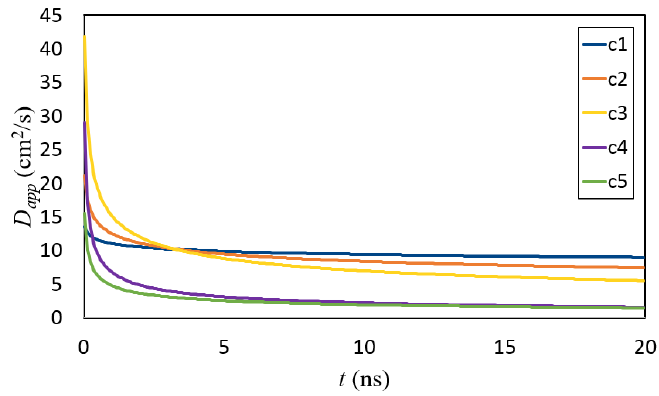
Figure 9. Apparent diffusion coefficient as a function of